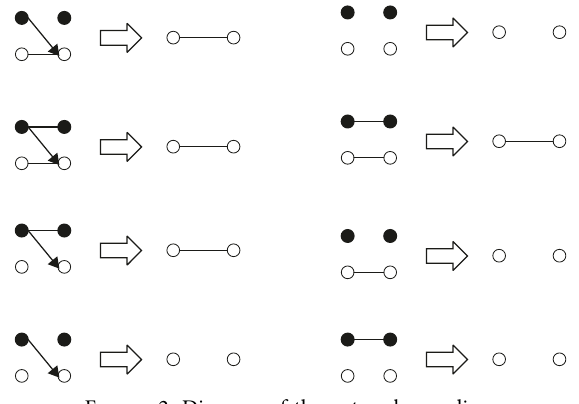
Figure 2: Diagram of the network coupling.